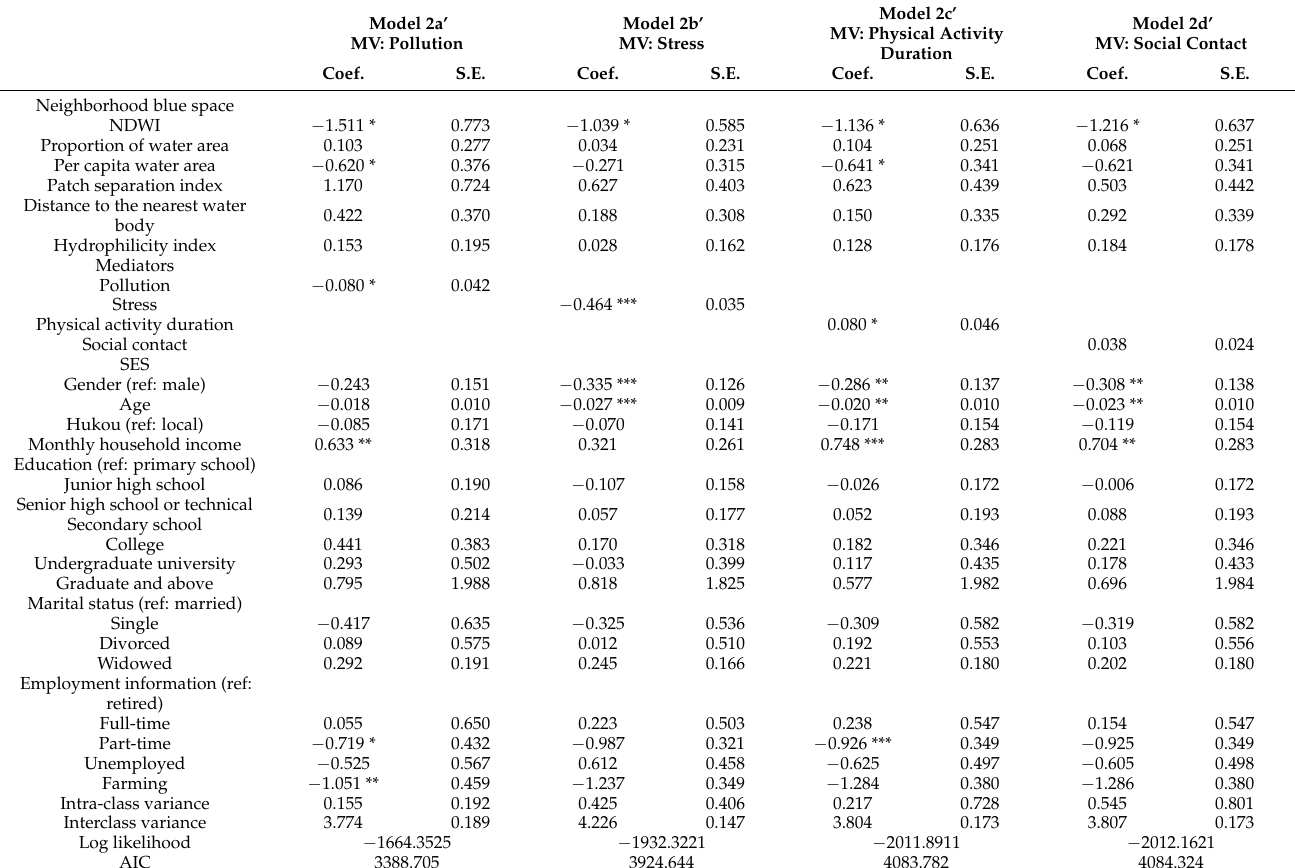
Table 4. Results of regressing neighborhood blue space on the